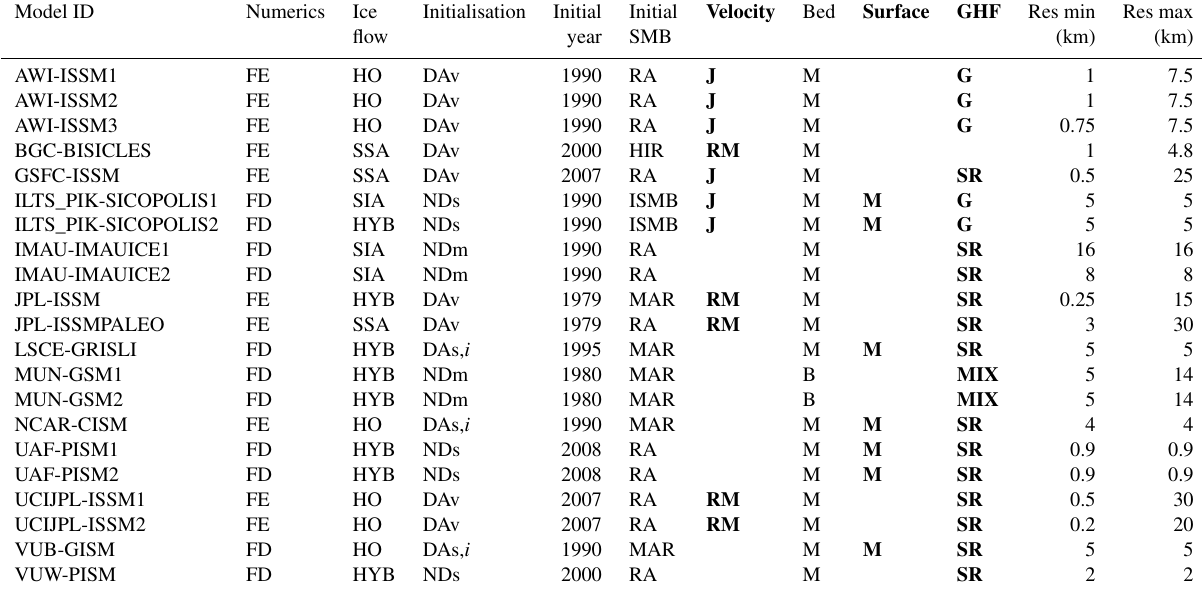
Table A1. Model characteristics used in the MIROC5 RCP8.5-forced GrIS MME considered in the study (adapted from Goelzer et al., 2020, their Appendix